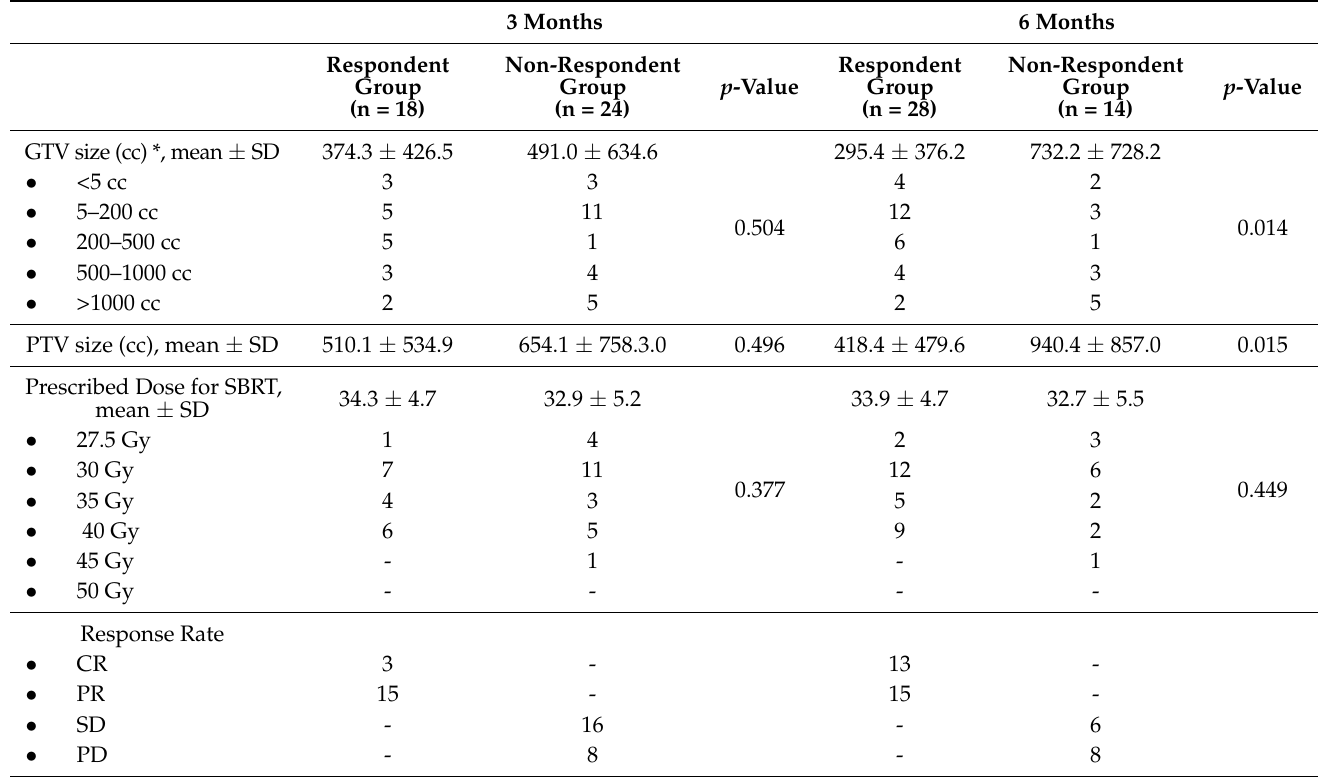
Table 2. Characteristics and response rates of the lesions in respondent and non-respondent groups in both studied timepoints. 3 Months 6 Months Respondent Non-Respondent Respondent p -Value Group Group Group (n = 18) (n = 24)